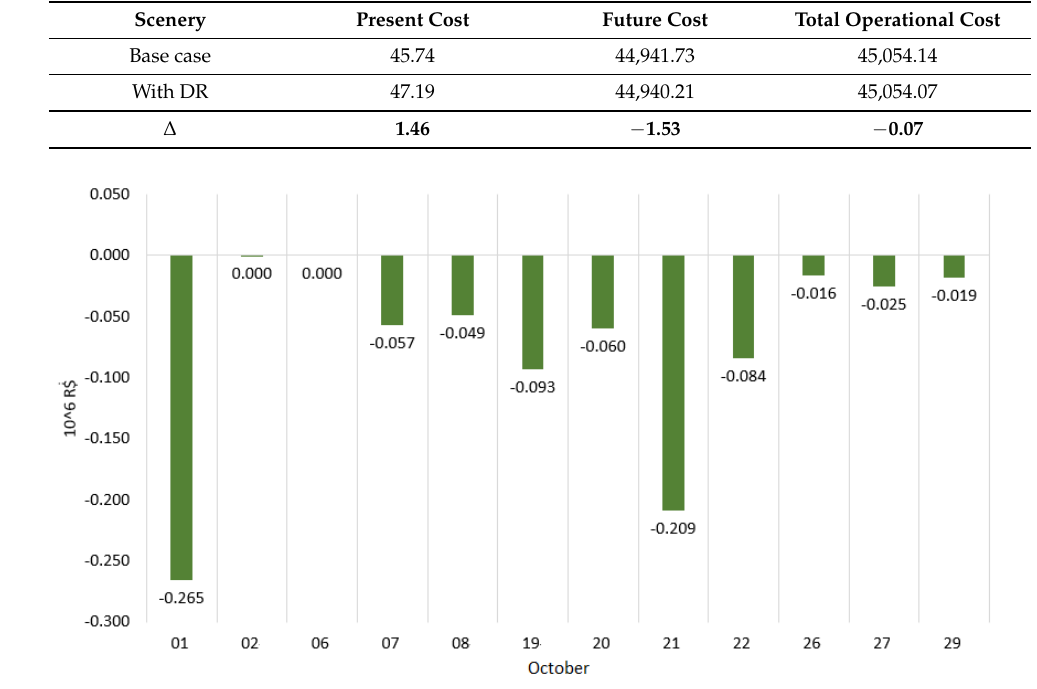
Table 7. Present, future, and total operational average cost (10 6 R$).